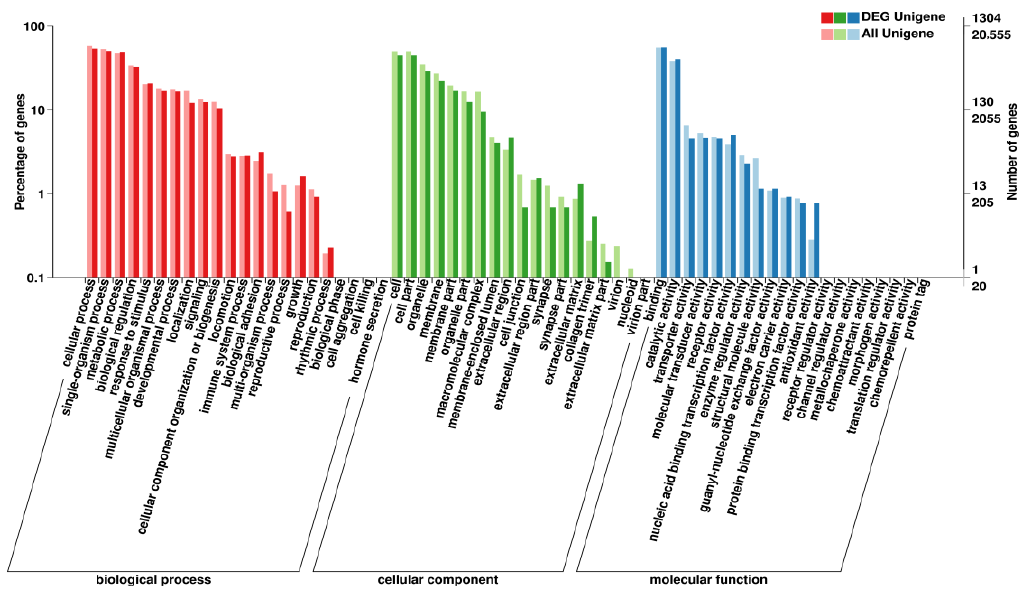
Figure 5. Clustering map of differentially expressed genes Gene Ontology (GO) in test group and control group. The abscissa is the GO classification, on the left of the ordinate is the percentage of the number of genes, and on the right is the number of genes. This figure shows the secondary function of each GO gene enrichment status in the background of the differentially expressed genes and the background of all the genes, thus reflecting the status of each secondary function in two backgrounds. The secondary function with significant difference indicates that the differentially expressed genes are different from the enrichment trend of all genes, and can be focused on whether this function is related to the difference.